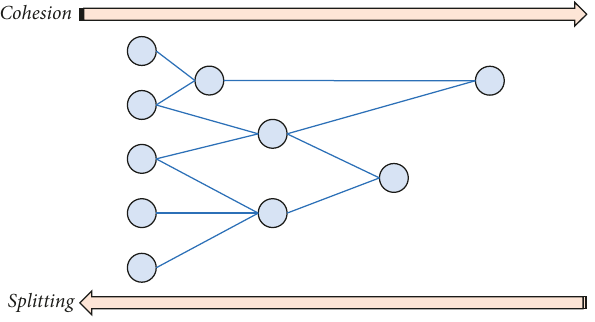
Figure 3: Process of hierarchical clustering.